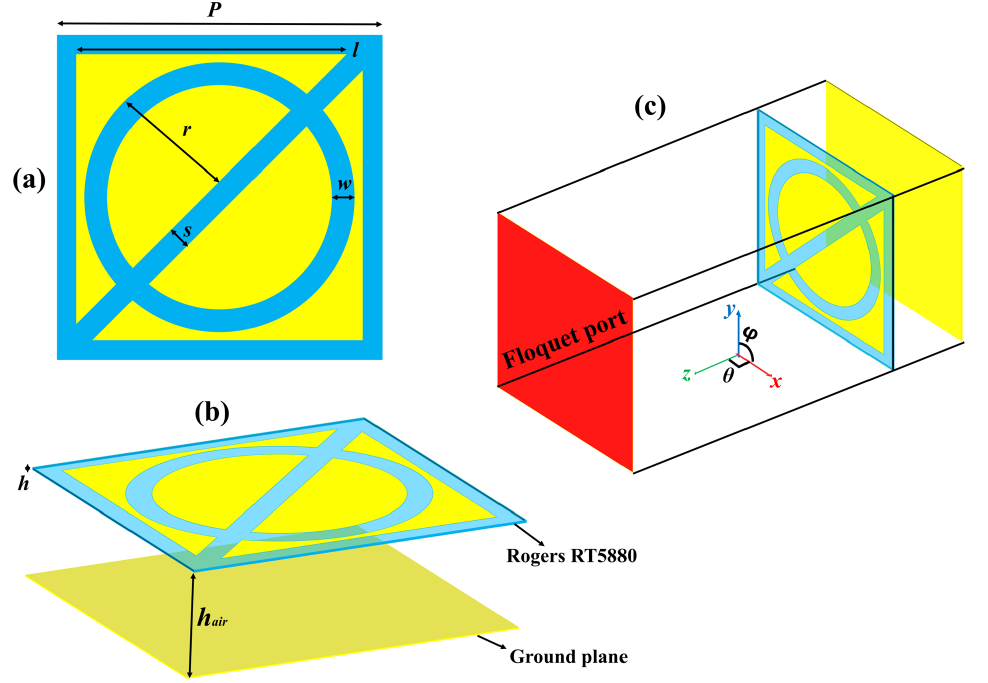
Figure 1. ( a ) Top and ( b ) side view of a meta-atom. P = 6 mm, l = 4.8 mm, r = 2.4 mm, s = 0.3 mm, w = 0.5 mm, h = 0.254 mm, and h air = 1.6 mm. ( c ) Three-dimensional view of simulation setup.